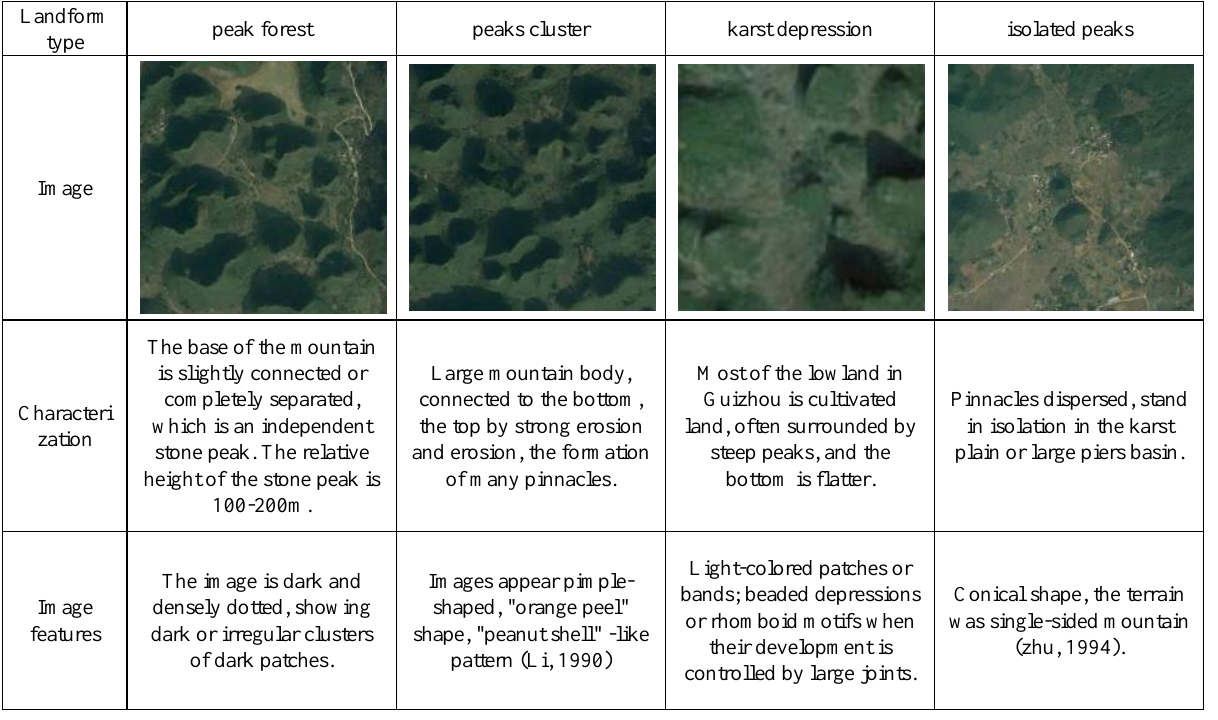
Table1. Table of karst landform image characteristics